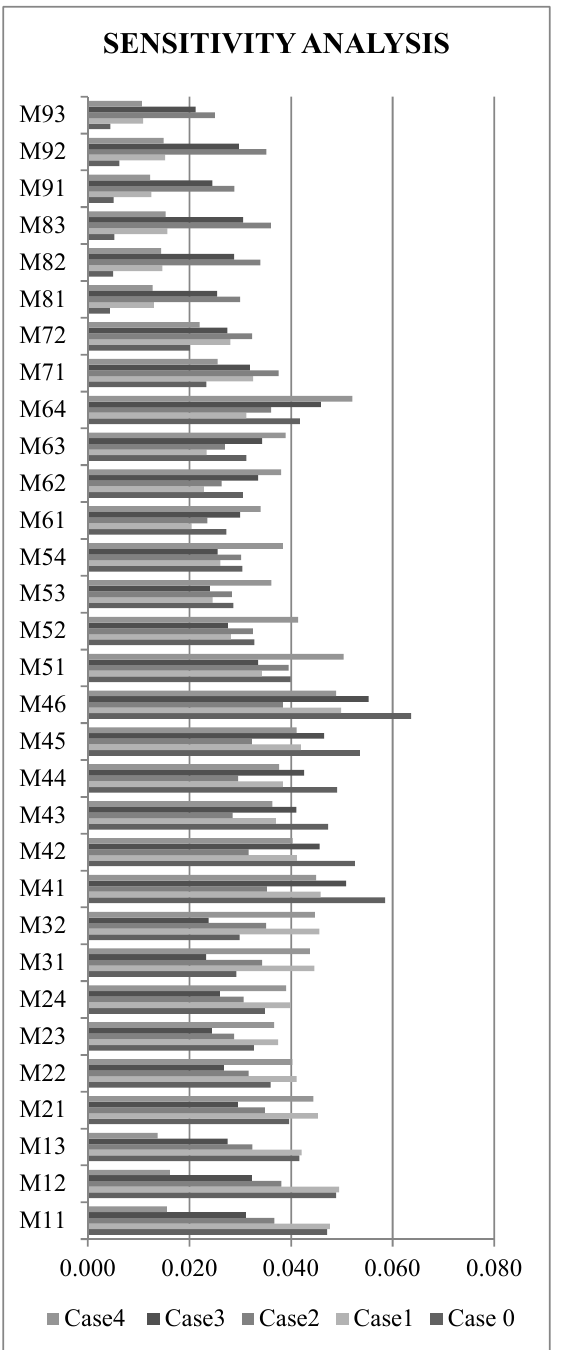
Fig. 3. Sensitivity